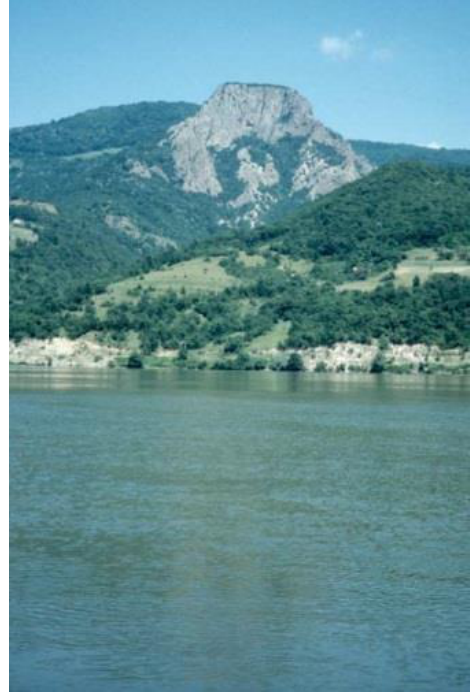
Figure 16. A view just across the Danube to the top Treskavac from Lepenski Vir settlement